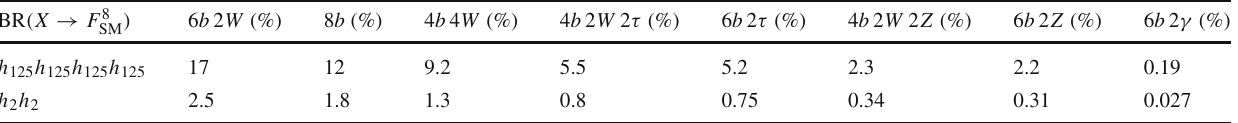
Table 4 Decay rates of the h 125 h 125 h 125 h 125 state in BP6 , leading to a eight-particle SM final state, F 8 rates originating from the